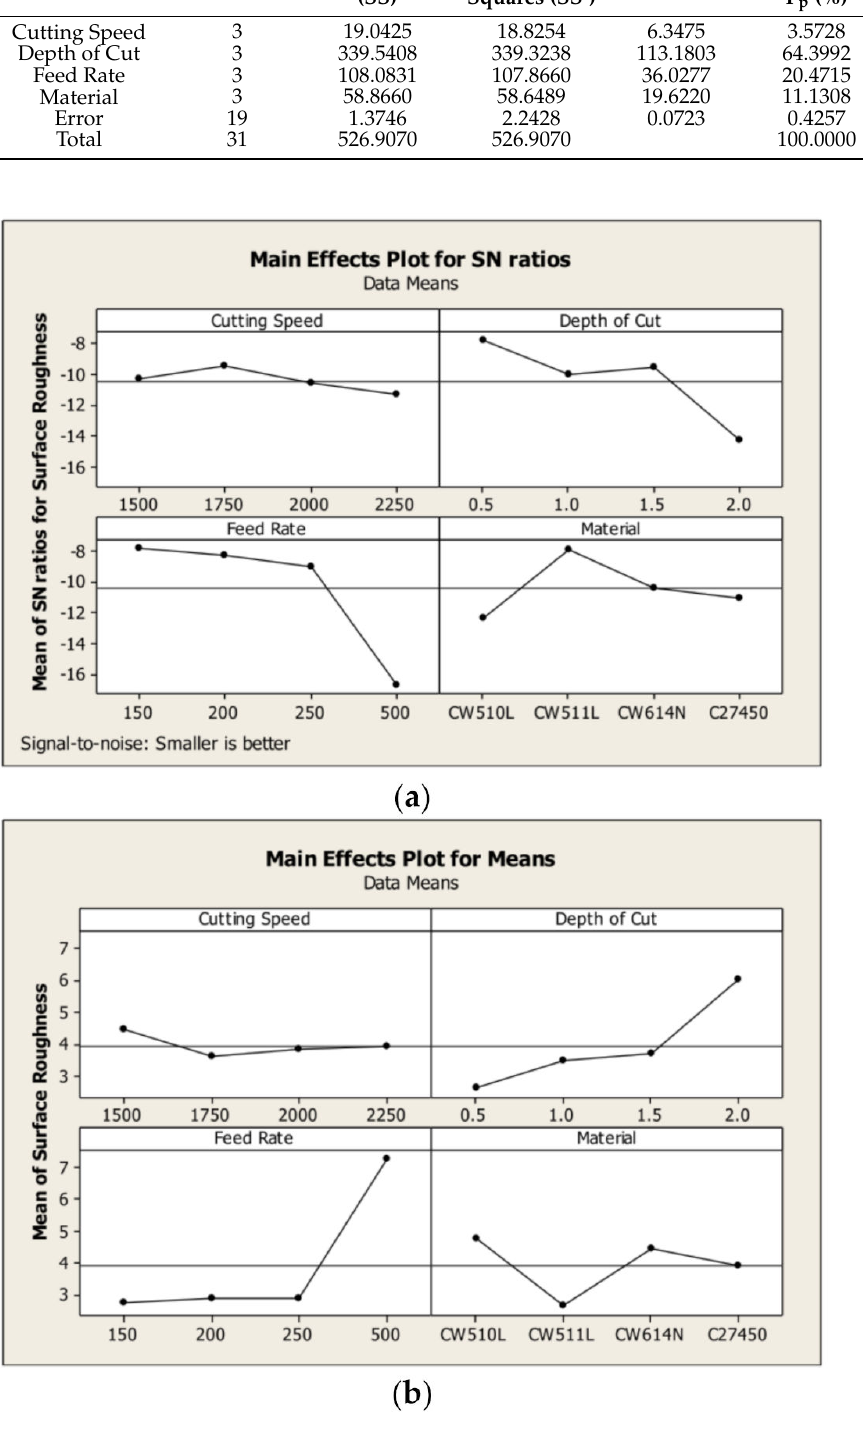
Figure 10. Diagrams showing the responses of ( a ) S/N ratios and ( b ) data means when evaluated against the cutting parameters which optimise the surface roughness